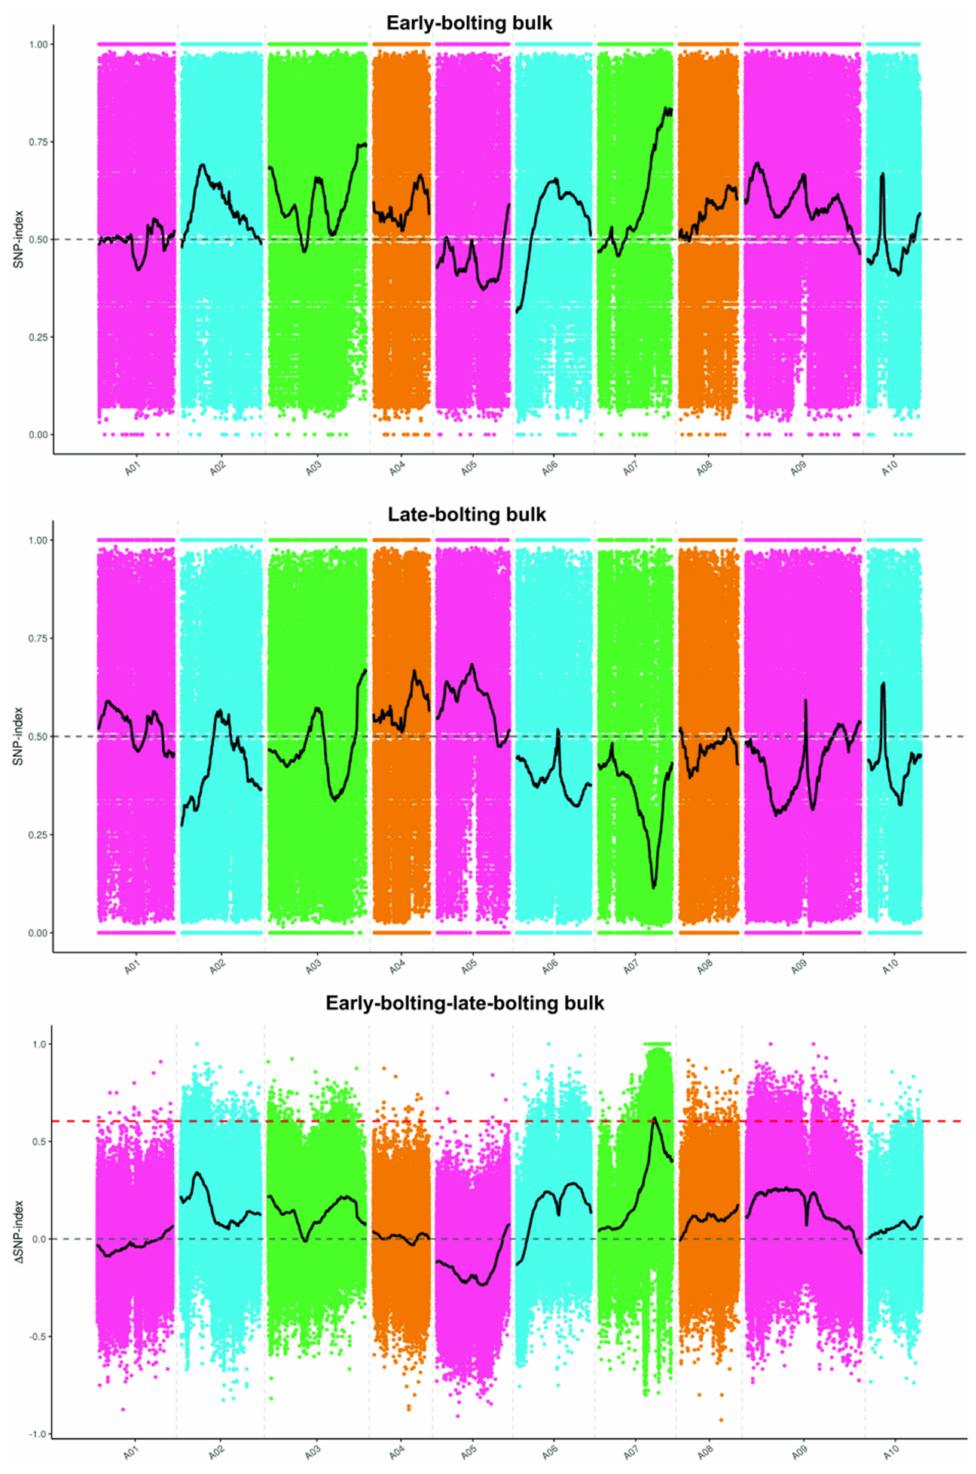
Figure 4. Mapping BrEb-1 by the SNP index method. The abscissa represents the chromosome name; the colored dots represent the calculated SNP index (or ∆ SNP index); the black line indicates the fitted SNP index. The top panel represents the distribution of SNP index values for early-bolting (recessive) bulk; the middle panel indicates the distribution of SNP index values for late-bolting (dominant) bulk; the bottom panel represents the distribution of ∆ SNP index values; the red dashed line represents the significant correlation